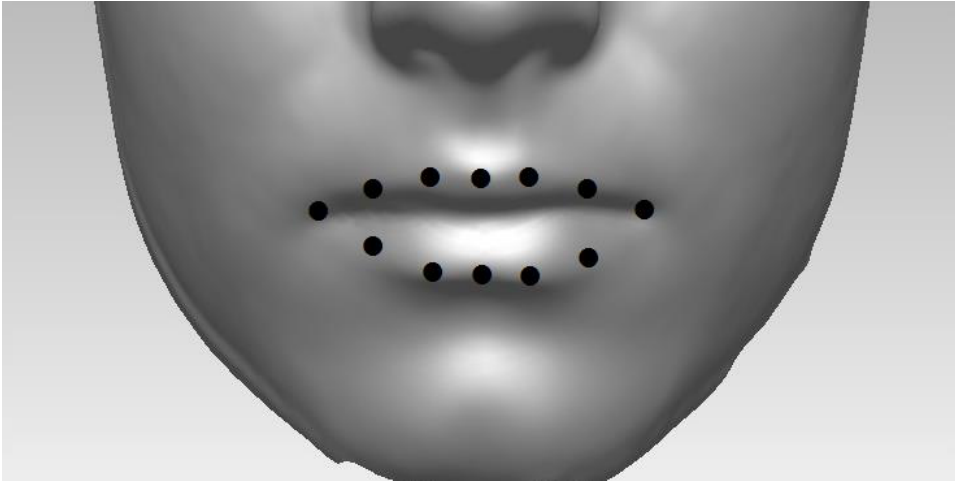
Figure 1. Illustration of lip shape, which is represented here by 12 landmark points placed on the 3D facial scans here.